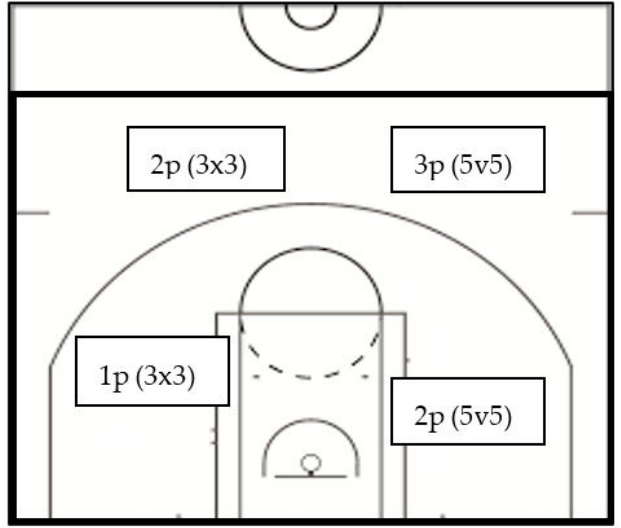
Figure 1. The 5v5 (grey) and 3x3 (black) half-court lines and shooting range of point values for each discipline—adapted from the official FIBA website [7].